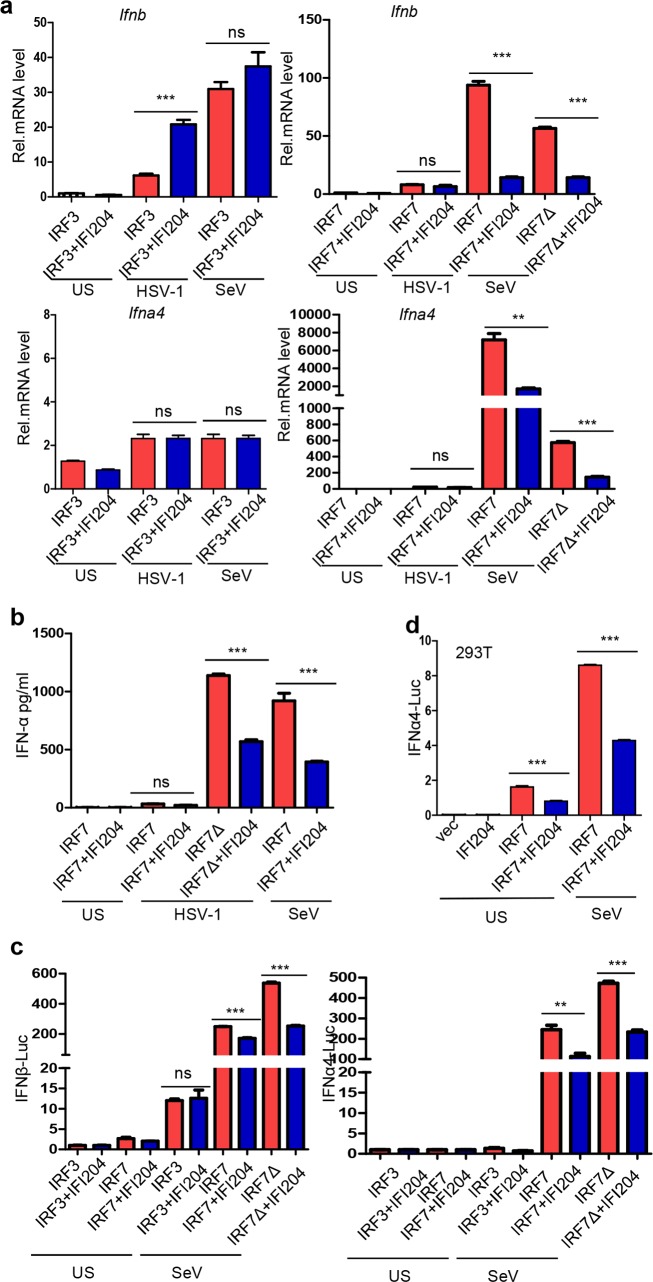
IFI204 inhibits IRF7-mediated activation of type I IFNs responses.(A) qRT-PCR analysis of Ifnb and Ifna4 in Irf3−/−Irf7−/−MEFs transfected with IFI204, IRF3, IRF7 or IRF7-Δ247–467 mutant (IRF7Δ) as indicated. 24 hrs post-transfection, cells stimulated with HSV-1 (MOI = 1) or SeV for 12 hrs as indicated. The unstimulated (US) treatment was used as a control. (B) ELISA analysis of the expression of IFNα in Irf3−/−Irf7−/−MEFs transfected with IFI204, IRF7 or IRF7-Δ247–467 mutant (IRF7Δ) as indicated. 24 hrs post-transfection, cells were stimulated with HSV-1 (MOI = 1) or SeV for 12 hrs as indicated. The unstimulated (US) treatment was used as a control. (C) Dual luciferase assays for analyzing the promoter activity of IFNβ (left panel) and IFNα4 (right panel) in Irf3−/−Irf7−/−MEFs co-transfected with 200 ng IFNβ or IFNα4 promoter luciferase reporter plasmids and 250 ng IFI204, IRF3, IRF7 or IRF7-Δ247–467 mutant (IRF7Δ) as indicated. The Renilla expression plasmid (pRL-TK, 10 ng) was co-transfected as an internal control. 24 hrs post-transfection, cells were stimulated with SeV for 12 hrs as indicated. The unstimulated (US) treatment was used as a control. (D) Dual luciferase assays for analyzing the promoter activity of IFNα4 in HEK293T cells co-transfected with 200 ng IFNα4 promoter luciferase reporter plasmid, 250 ng IFI204 and IRF7 as indicated. The Renilla expression plasmid (pRL-TK, 10 ng) was co-transfected as an internal control. 24 hrs post-transfection, cells were stimulated with SeV for 12 hrs as indicated. The unstimulated (US) treatment was used as a control. Not significant (ns), **P < 0.01 and ***P < 0.001. Data are representative of three independent experiments (mean ± SD in A-D).